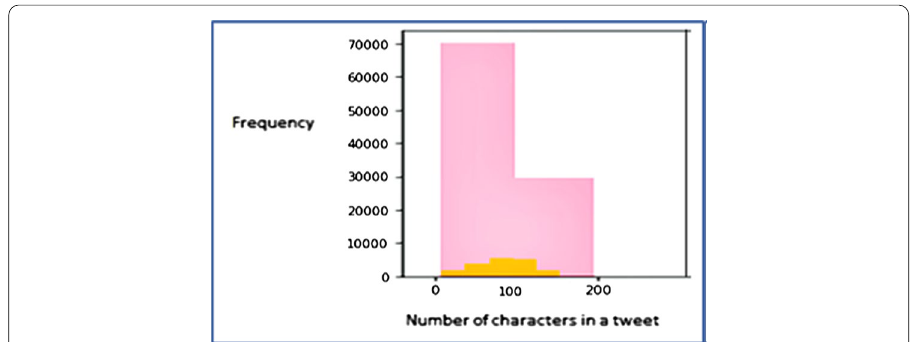
Fig. 7 Distribution of tweets in the training and testing